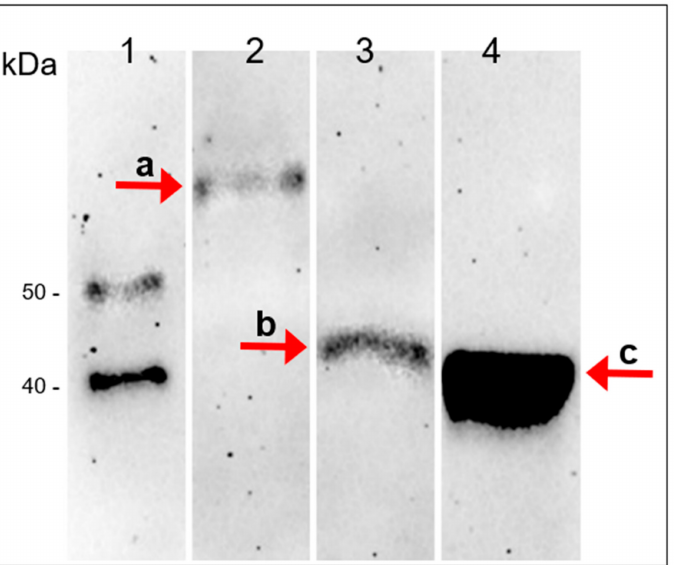
Figure 7. Presence of A561L protein in the PBCV-1 virion. Western blot of PBCV-1 proteins against anti A561L D4 antibody (AB) produced in mice. ( 1 ). protein ladder; ( 2 ). untreated virus; ( 3 ). virus treated with 5 M LiCl (vLysin); ( 4 ). recombinant A561L D4 . Band a full length A561L protein ~72 kDa; band b processed fragment of A561L ~44 kDa (vLysin activity); band c recombinant A561L D4 protein ~42 kDa (the A561LD 4 domain is ~27 kDa plus His-Patch thioredoxin, V5 epitope tag and 6xHis